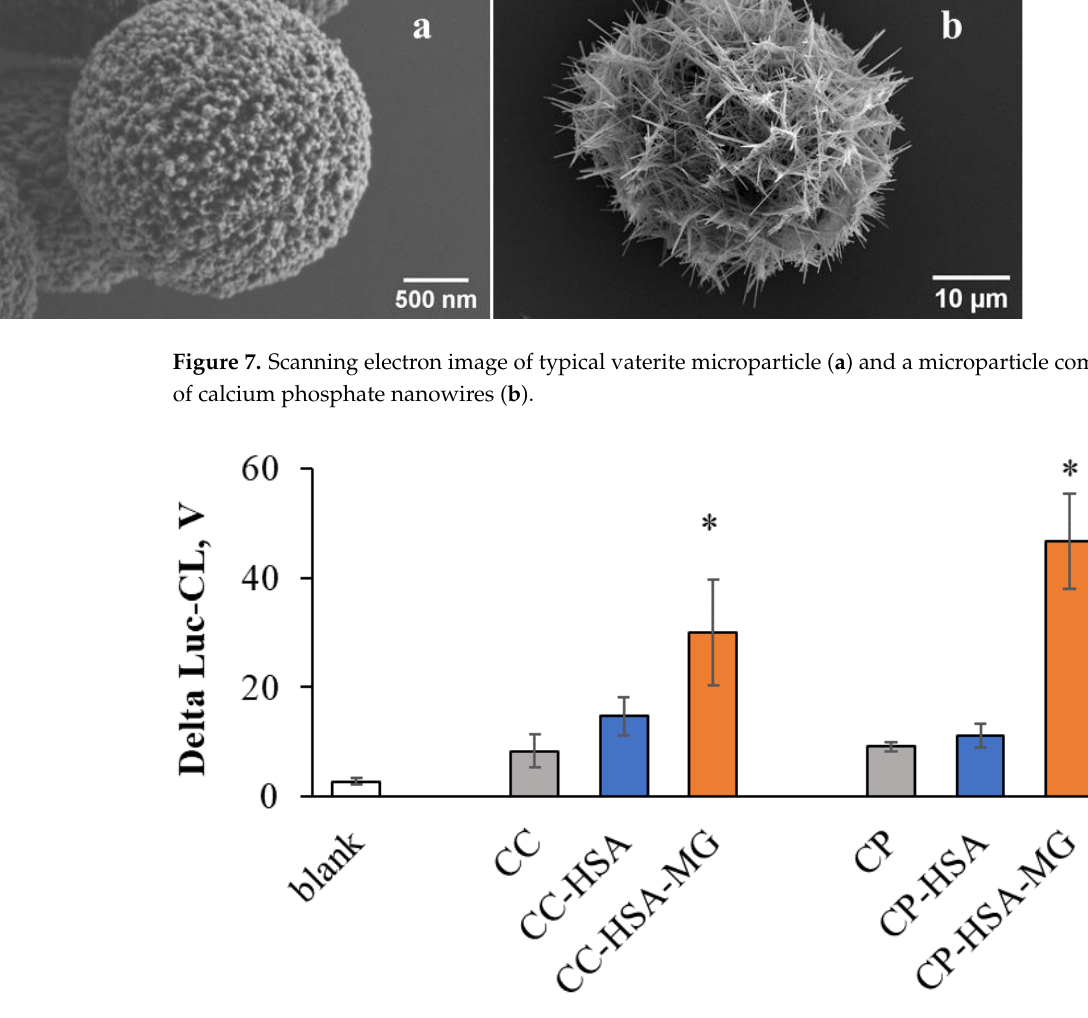
Figure 8. Amplitude of neutrophil Luc-CL, stimulated by vaterite (CC) or hydroxyapatite (CP) microparticles before and after coating with HSA or HSA-MG. Microparticle concentration: 1 mg/mL, neutrophil concentration: 0.5 × 10 6 cells/mL. As a blank control, 0.15 M NaCl solution was added to neutrophils. Each bar represents the mean value of three independent experiments. * p < 0.05 vs. the same untreated microparticles or microparticles coated with HSA, according to Student’s t